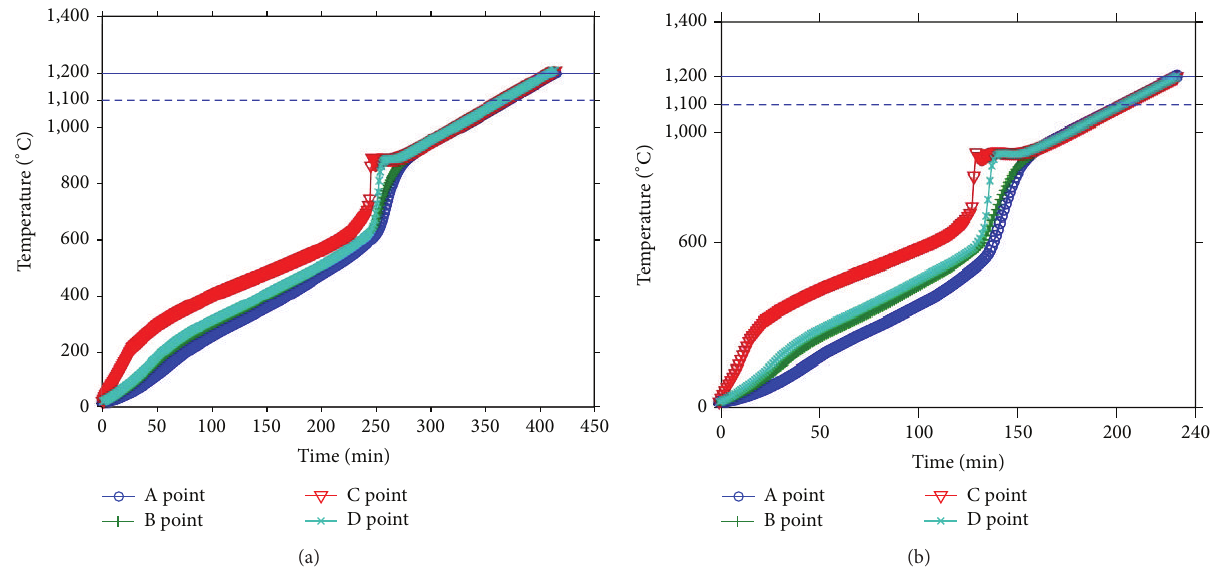
Figure 4: Plots of temperatures of four reference points versus heating time in the microwave heating process for (a) single-source and (b) double-source microwave